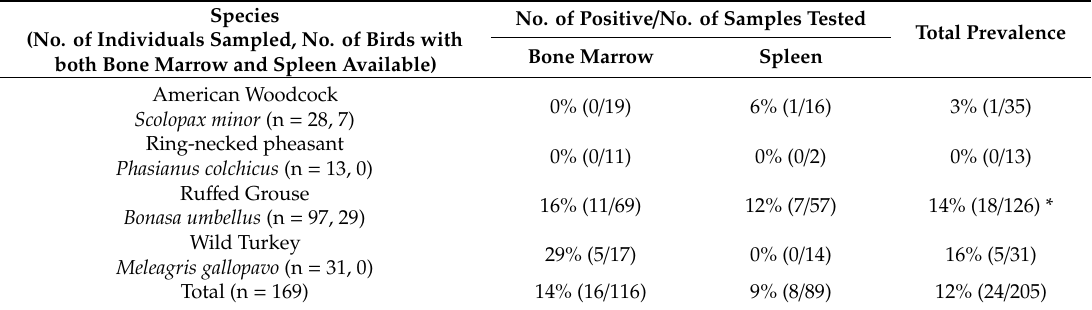
Table 1. Number of individual upland game birds and sample type (bone marrow, spleen) from Pennsylvania and prevalence of Borrelia burgdorferi